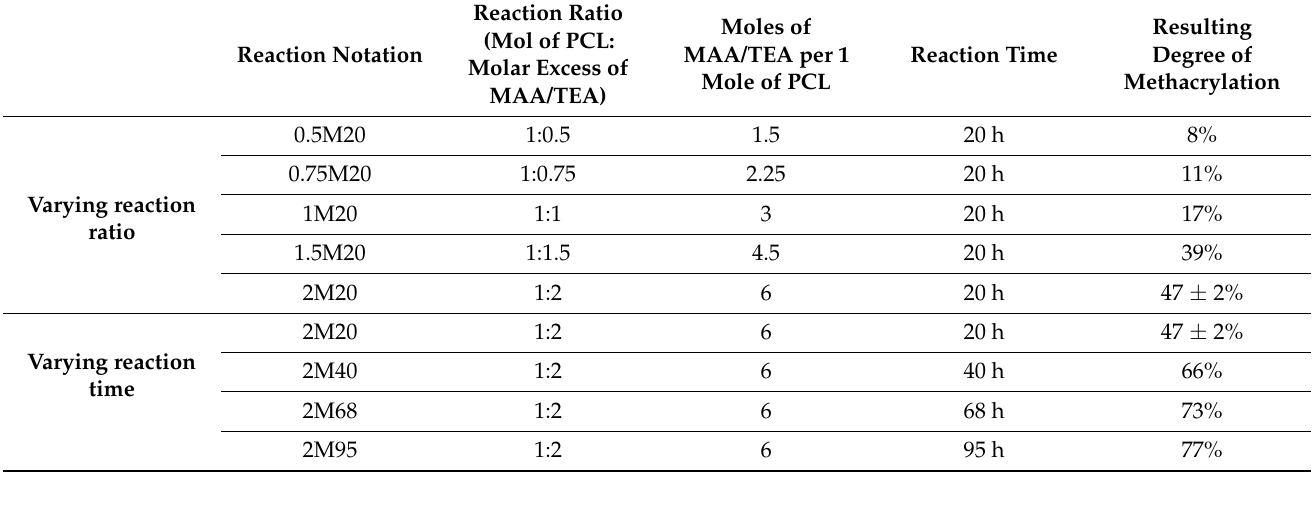
Table 1. Reaction parameters used to produce PCLMA and the resulting degree of methacrylation (DM). DM was altered by varying the molar ratio of reactants and the reaction time. N = 1, n = 1, except for 2M20 where N = 3, n = 1 so mean ± SD shown only for 2M20.